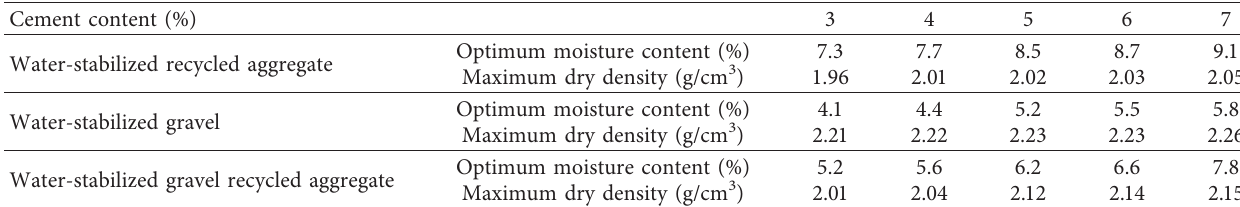
Table 5: The test methods table.